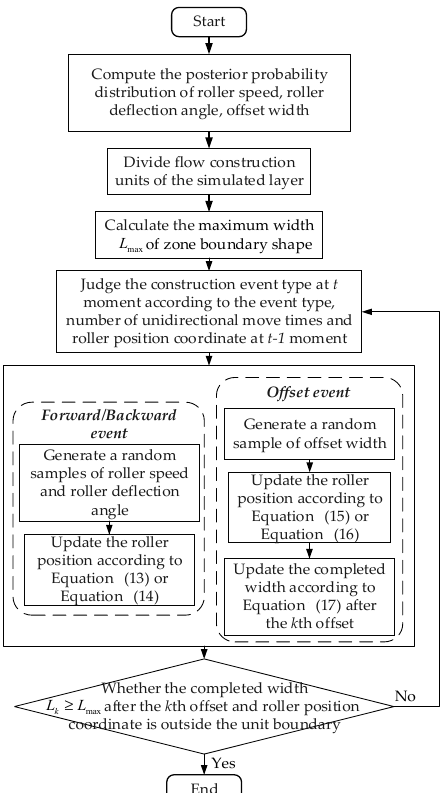
Figure 3. Flowchart of the proposed adaptive compaction construction simulation model.